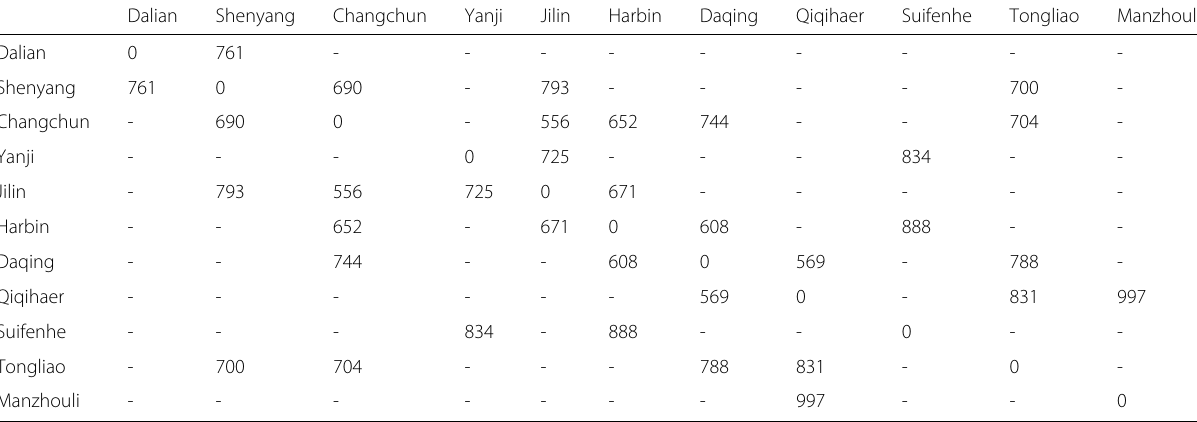
Table 6 Unit cost of an empty container in railway transport (CNY)